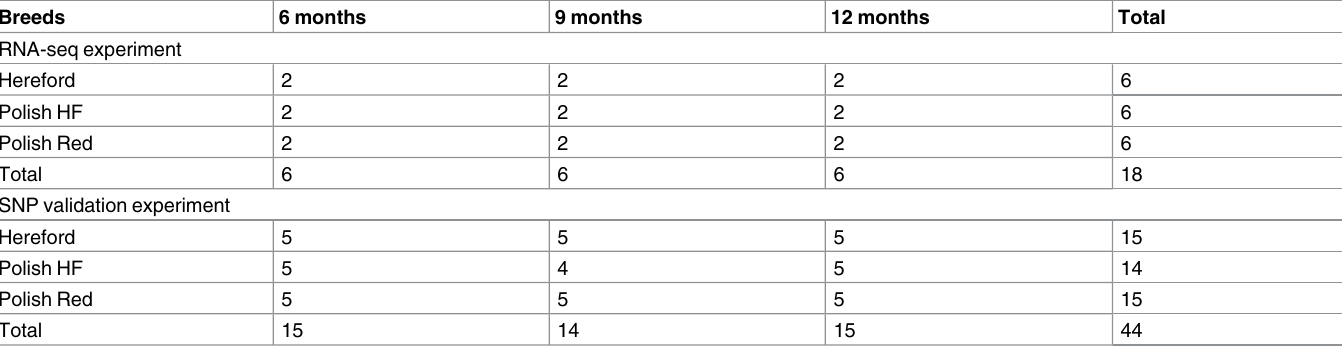
Table 6. The distribution (n) of investigating young bulls in a breed-specific experimental design representing bovine liver transcriptome. Breeds